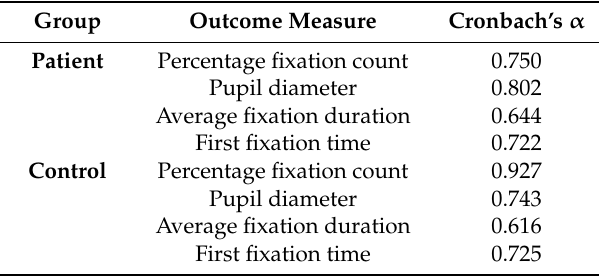
Table 1. Internal consistency measured with Cronbach’s alpha for each outcome variable in the patient and control group.